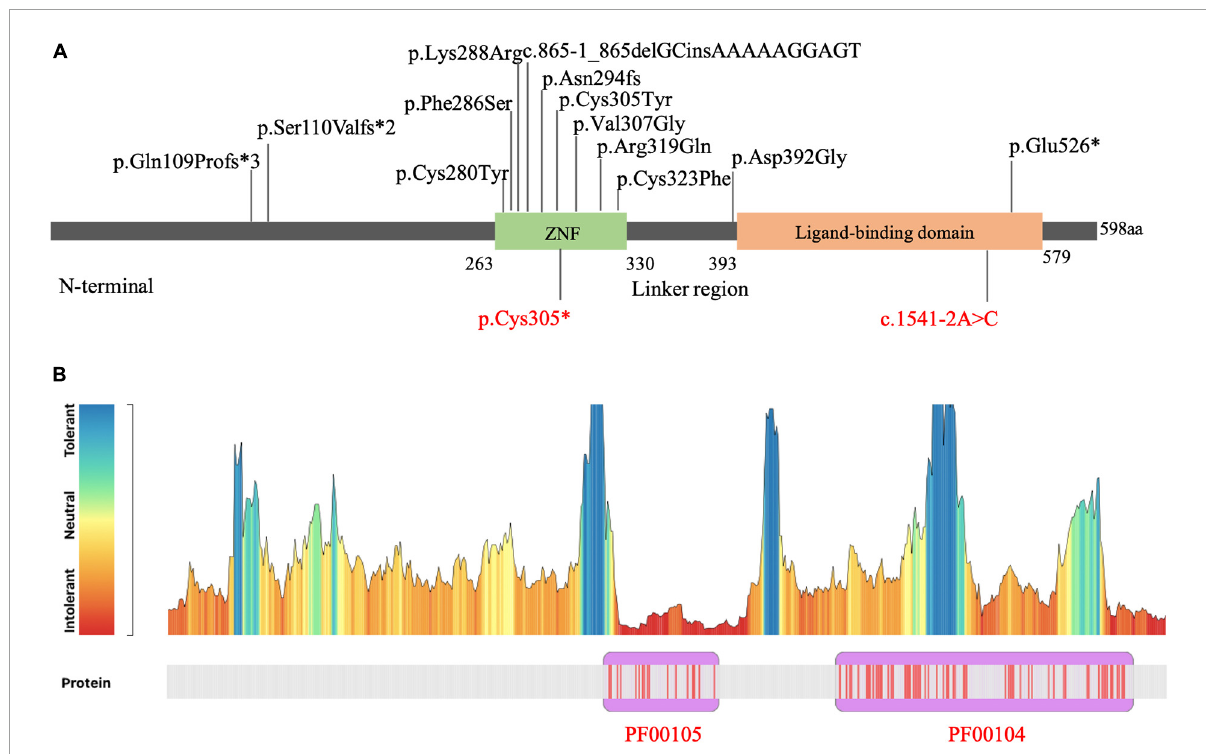
FIGURE3 Distribution of NR4A2 variants. (A) Schematic view of the domain distribution of variants in NR4A2. The variants identified in the present study (in red) and previous studies (in black). (B) NR4A2 missense variation tolerance landscape. The tolerance landscape depicts a missense over synonymous ratio which are annotated from gnomAD dataset. Pkinase Pfam protein domains are shown in purple. PF00105 is clearly seen as intolerant to missense variation compared to other parts of